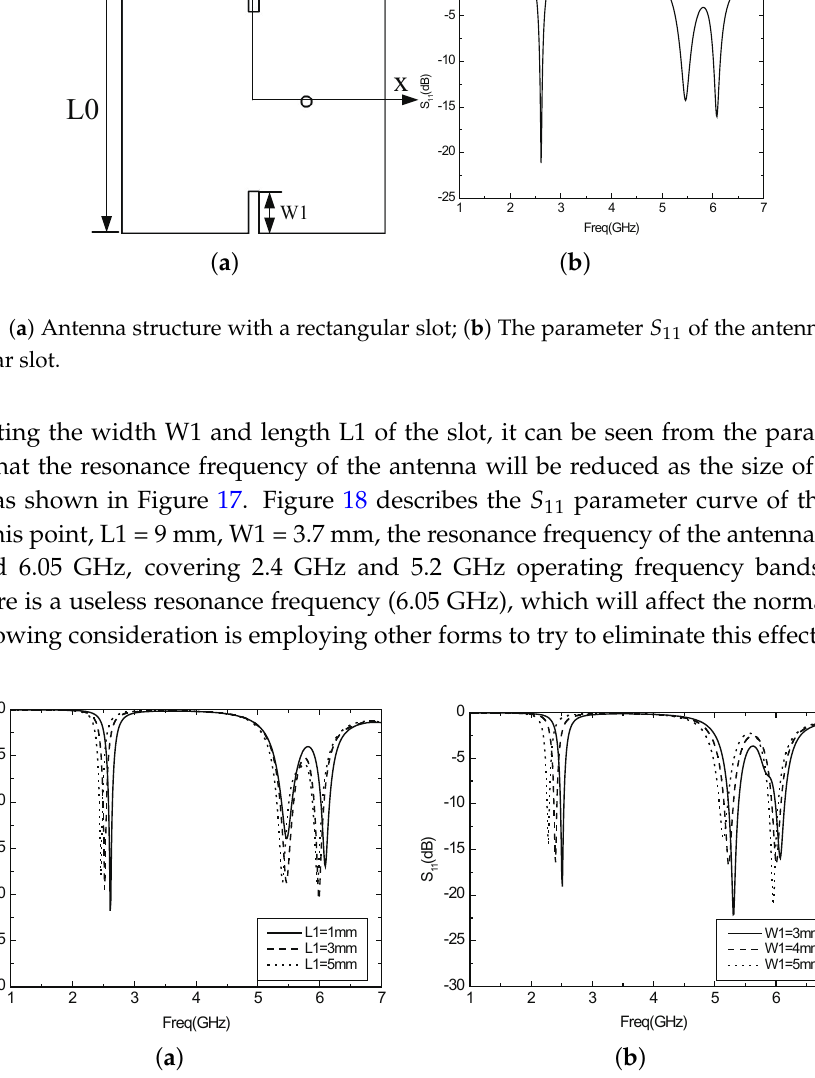
Figure 17. ( a ) The parameter S 11 varies with L1 when opening the rectangular slot; ( b ) The parameter S 11 varies with W1 when opening the rectangular slot.